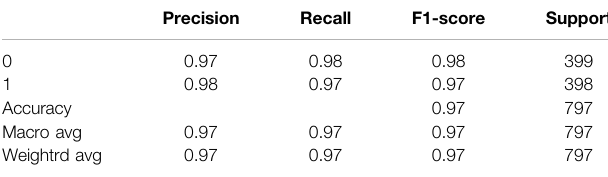
TABLE 1 | Evaluation indexes of textRNN model on the functional domain. Precision